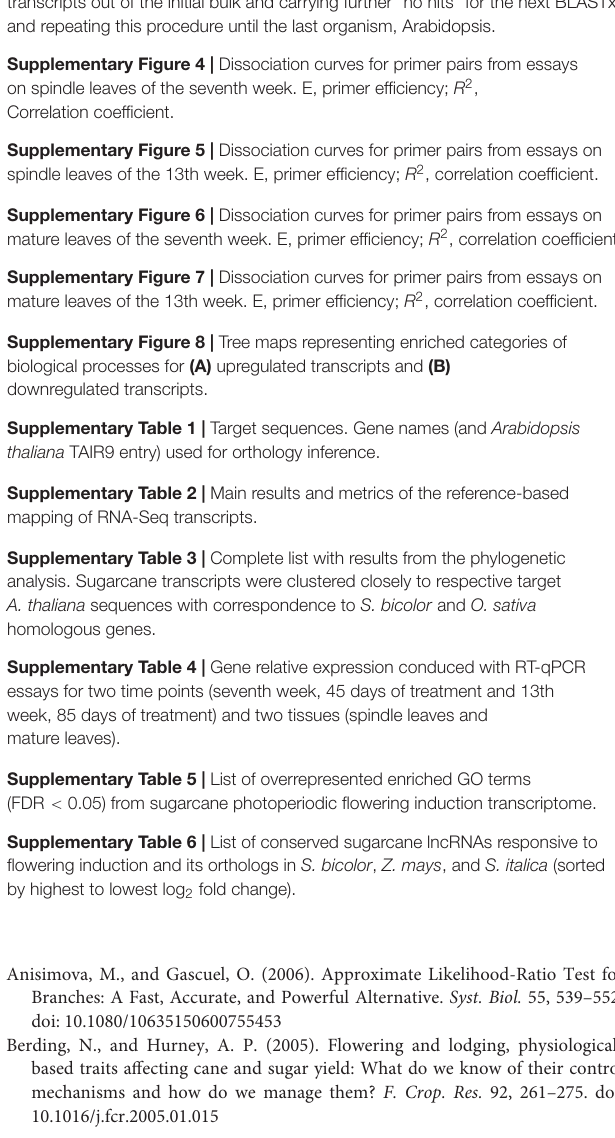
Supplementary Figure 1 | Schema of the sugarcane leaf structure, emphasizing the spindle leaves (top red circle), and the first leaf from the top to the bottom of the stalk with clearly visible dewlap (bottom red circle) also known as +1 mature leaf (adapted from Van Dillewijn, C. Botany of sugarcane. Waltham: Chronica Botanica, 1952. 371). (A) sagittal section of the upper culm: peeled, (B) spindle leaves dissected from the central part of the upper culm, (C) shoot apical meristem dissected from the bottom part of the upper culm, and (D) +1 mature leaf with red arrow showing the dewlap. Supplementary Figure 2 | Morphology of the shoot apical meristem of sugarcane cultivar IACSP96-7569: (A) seventh week, 45 days in inductive conditions; (B) seventh week, 45 days in non-inductive conditions; (C) 13th week, 85 days in inductive conditions; and (D) 13th week, 85 days in non-inductive conditions (Santos et al., 2021). Supplementary Figure 3 | Subtractive approach conducted to annotate sugarcane transcripts. All 191,816 transcripts were considered for annotation using successive BLASTx steps with sorghum, corn, wheat, rice, and Arabidopsis protein databases. Alignments produced in each step were filtered for coverage and identity between query and subject sequences, taking “hit” transcripts out of the initial bulk and carrying further “no hits” for the next BLASTx and repeating this procedure until the last organism, Arabidopsis. Supplementary Figure 4 | Dissociation curves for primer pairs from essays on spindle leaves of the seventh week. E, primer efficiency; R 2 , Correlation coefficient. Supplementary Figure 5 | Dissociation curves for primer pairs from essays on spindle leaves of the 13th week. E, primer efficiency; R 2 , correlation coefficient. Supplementary Figure 6 | Dissociation curves for primer pairs from essays on mature leaves of the seventh week. E, primer efficiency; R 2 , correlation coefficient. Supplementary Figure 7 | Dissociation curves for primer pairs from essays on mature leaves of the 13th week. E, primer efficiency; R 2 , correlation coefficient. Supplementary Figure 8 | Tree maps representing enriched categories of biological processes for (A) upregulated transcripts and (B) downregulated transcripts.